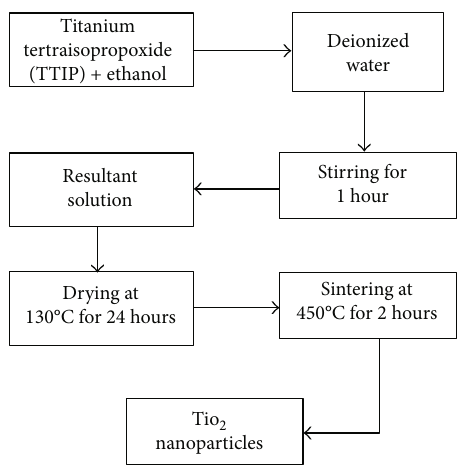
Figure 3: Preparation fl owchart of TiO